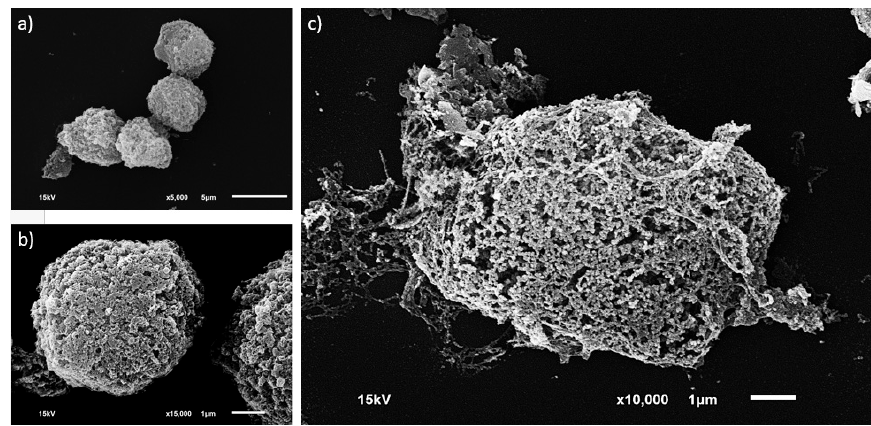
Figure 7. Scanning electron microscopy (SEM). ( a ) The figure illustrates a group of viably non- Figure 7. degenerated MCT cells harvested after sorting in this study. Most cells were round and aggregated.